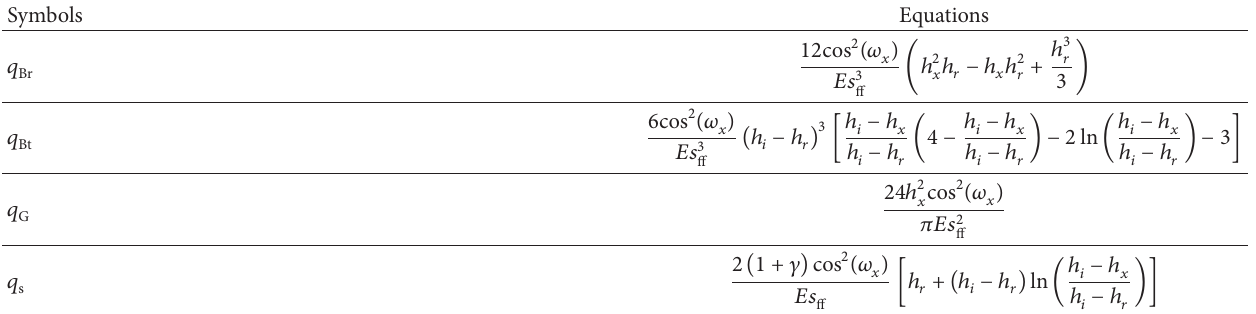
Table 1: Pinion tooth flexibilities associated with dedendum fatigue cracks.